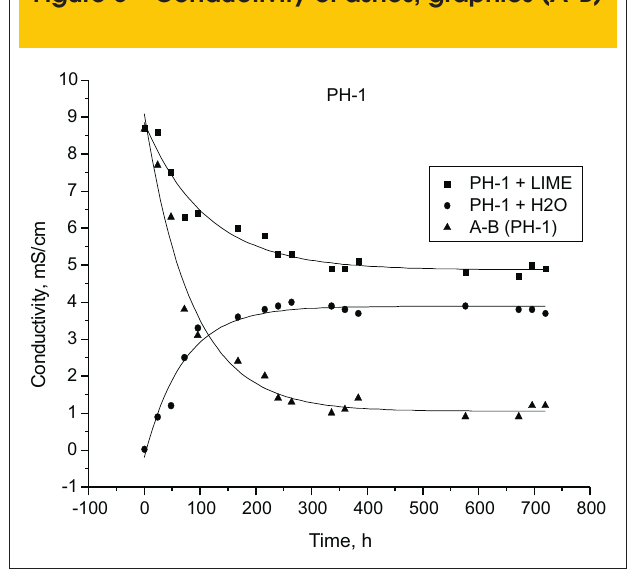
Figure 6 – Conductivity of ashes, graphics (A-B)